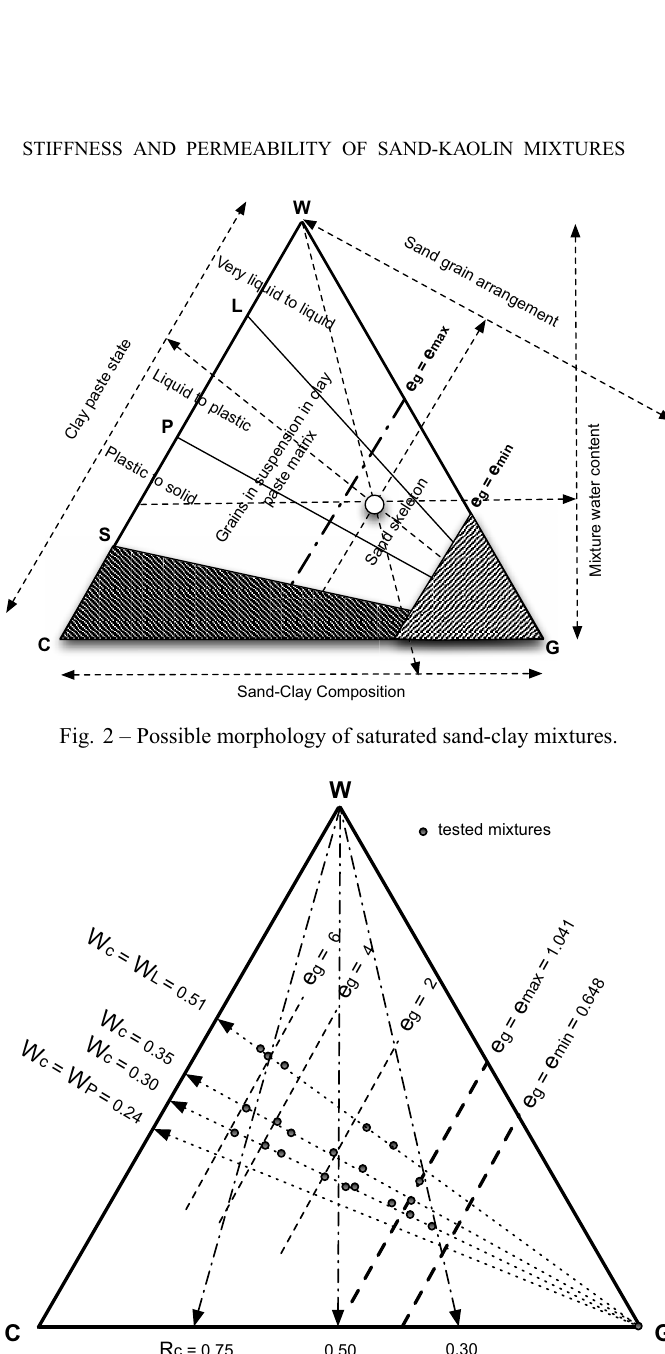
Fig. 3 – Triangular representation of the tested sand clay